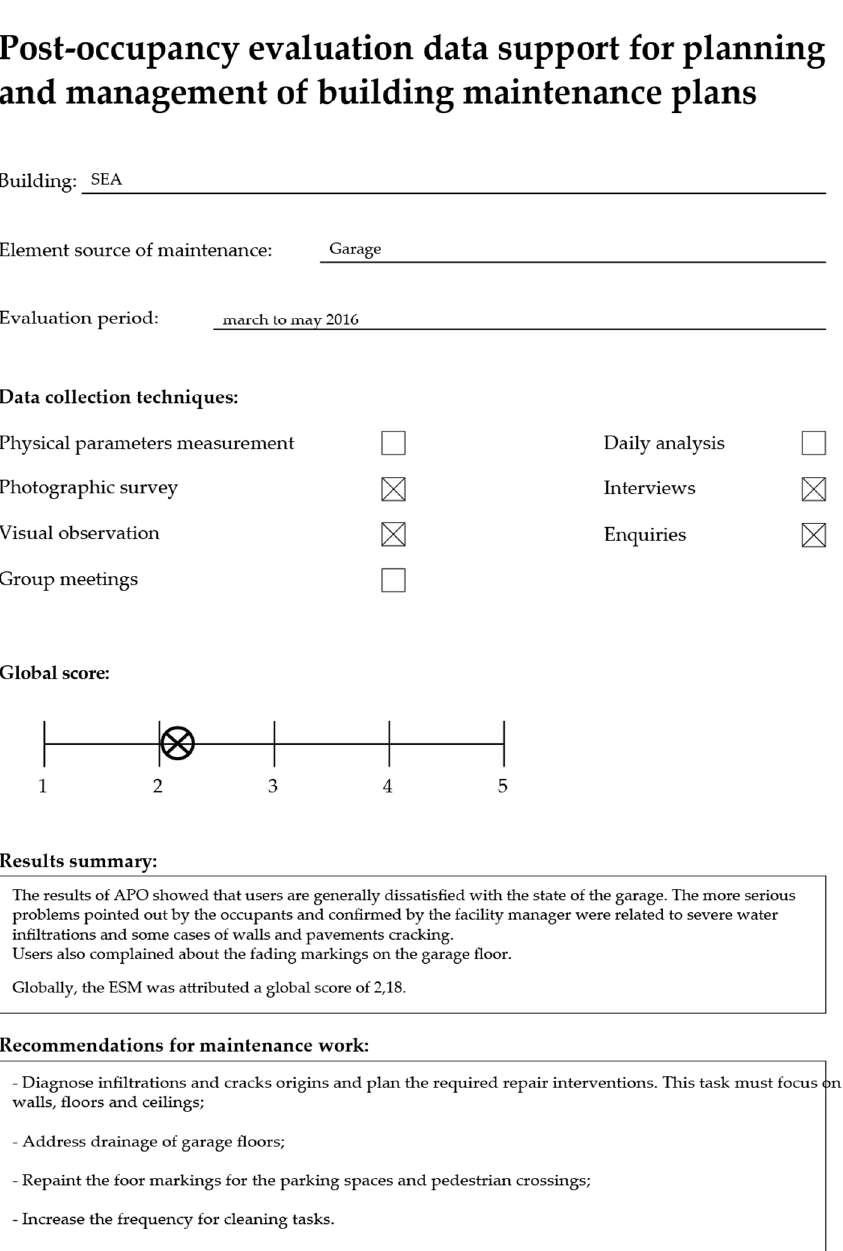
Figure 3. Maintenance sheet example.